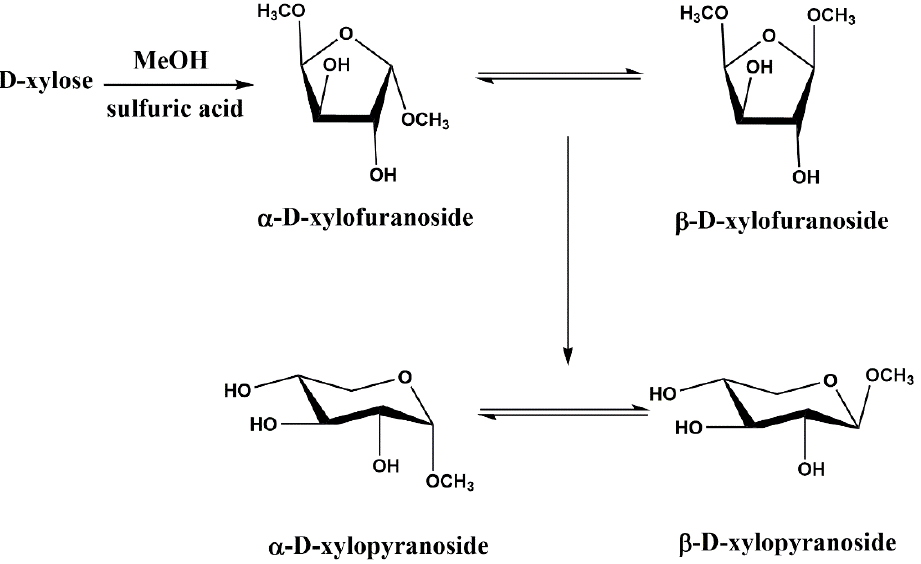
Figure 2. Methanolysis of D-xylose to pyranosides via the Fisher reaction [44].